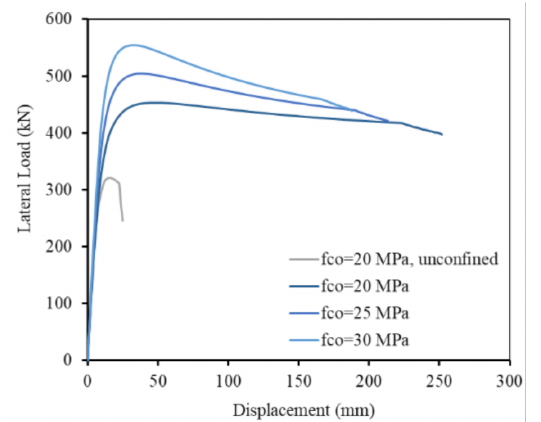
Figure 18. Lateral load-displacement curves according to concrete strength (S-S